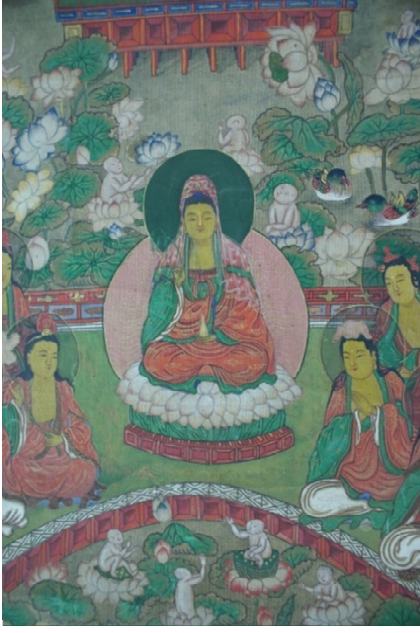
Figure 12. Detail of Three Gates in a Single Mind showing Avalokiteśvara Bodhisattva in the central frame. Photograph by Choi Yeub.